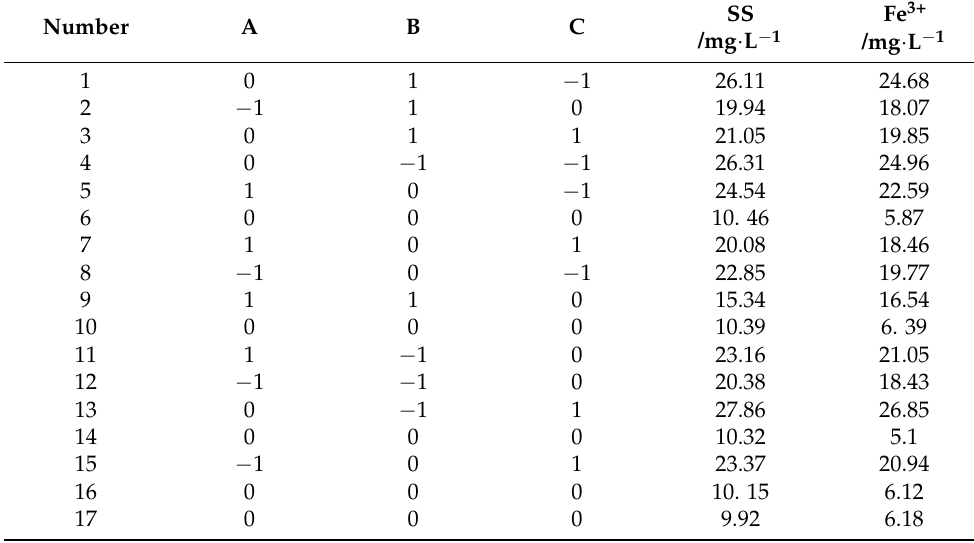
Table 3. The test scheme and